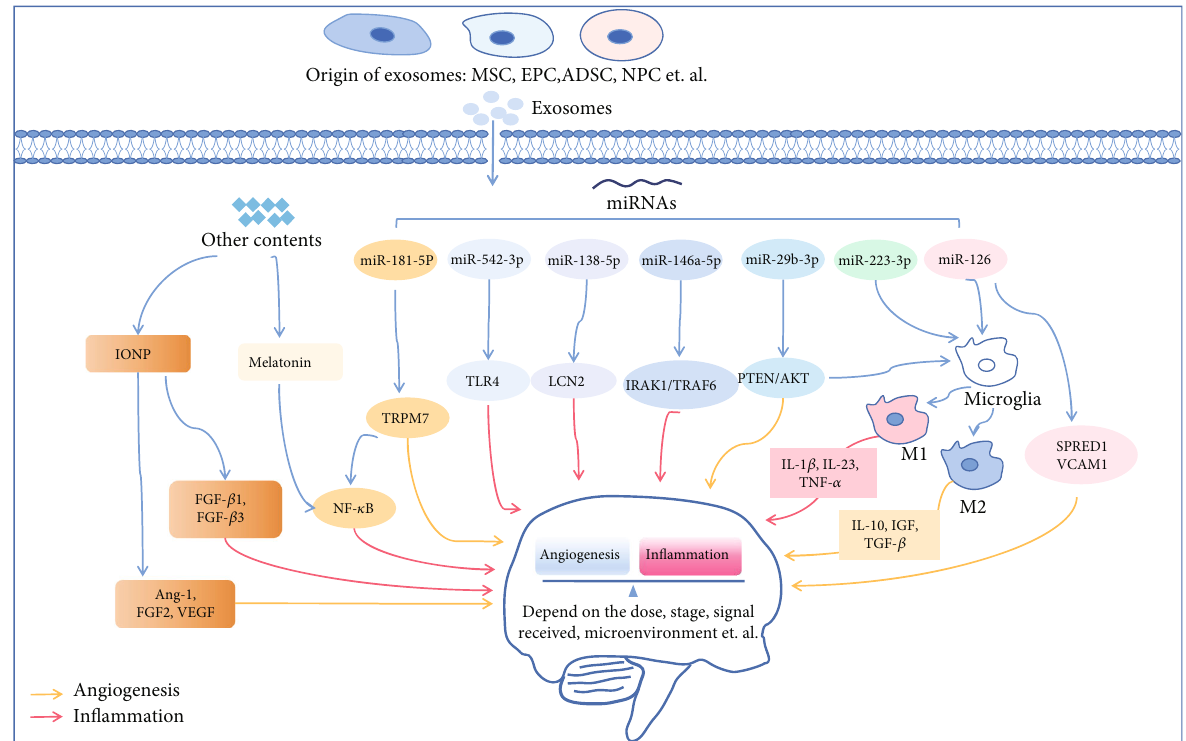
Figure 2: Summary of the exosomes in crosstalk between in fl ammation and angiogenesis. The red arrow represents regulation of in fl ammatory response, the yellow arrow represents regulation of angiogenesis, and the blue arrow represents general regulation. Exosomes from di ff erent sources carry miRNAs and other contents that a ff ect central nervous system cells and simultaneously regulate in fl ammation and angiogenesis through di ff erent signals. The balance between in fl ammation and angiogenesis is also in fl uenced by many factors following stroke, including the pathological stage of stroke, the signal received, and the dose of therapeutic